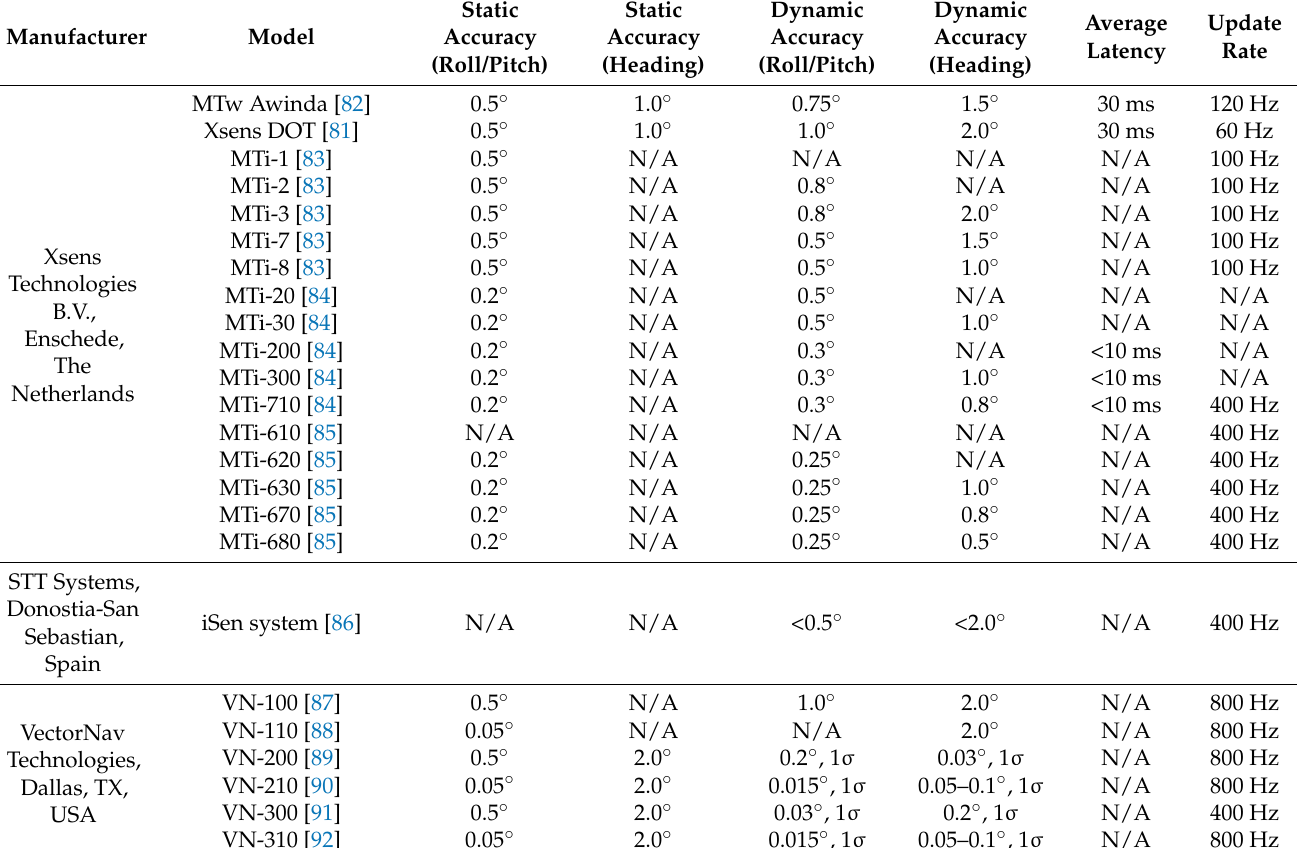
Table 3. Summary of commercially available inertial tracking